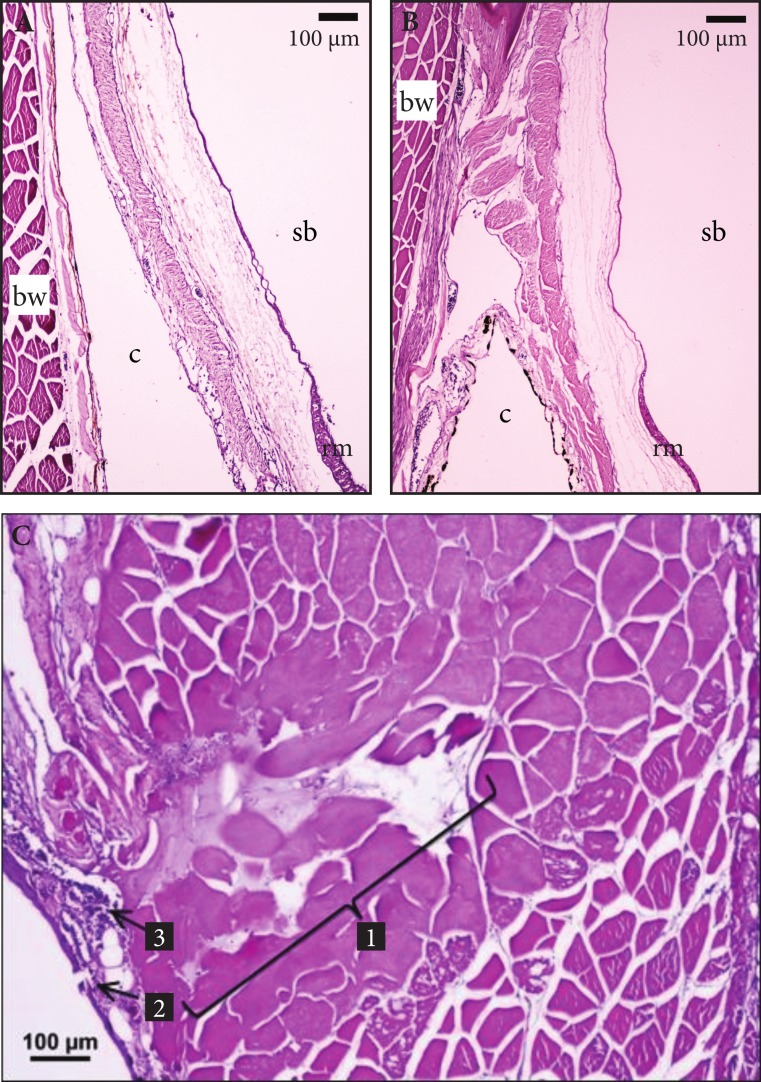
Histologic views of swim bladder tissues in vented Yellow Tang.(A)–(B) Representative histologic views of normal Yellow Tang swim bladder tissues in vented fish at (A) 0 days and (B) 21 days. Note lack of any inflammation, edema, or necrosis in lateral body wall (bw), coelomic cavity (c) swim bladder (sb), and rete mirable (rm). (C) Histologic section of needle track in a Yellow Tang subjected to venting showing muscle cell necrosis, edema, and neutrophilic inflammation: (1) Needle track, (2) needle entry through coelomic cavity, (3) neutrophilic inflammatory response.